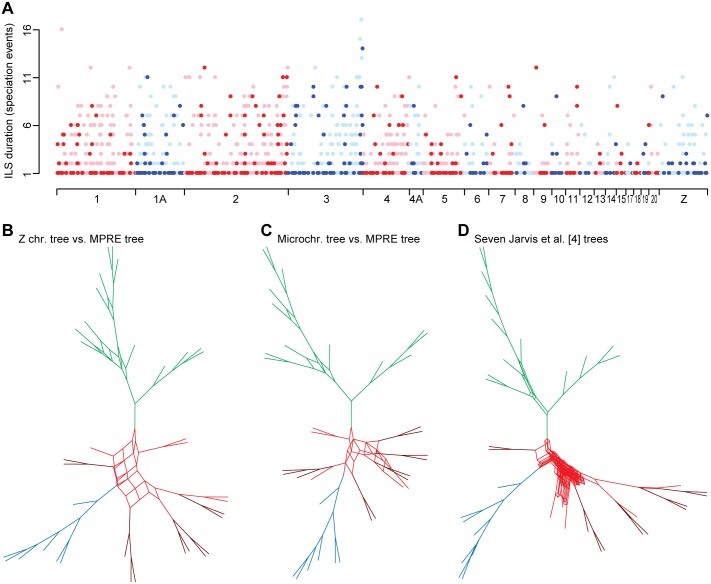
Genomic location of rare genomic changes reveals prevalence of incomplete lineage sorting across all chromosomes.(A) Distribution of RE markers across the chromosomes of the zebra finch genome plotted against per-marker count of speciation events during which respective ILS persisted (S1 Table). Locations of intronic markers are indicated in dark colors, while putatively intergenic markers are denoted in light colors. (B–D) Supernetworks [31] illustrate the complex reticulations of topology conflicts between compared trees. These conflicts exhibit highly similar distributions (cf. Fig 4A) in supernetwork comparisons between the MPRE tree (Fig 1B, S2 Data) and a tree based on 114 Z-chromosomal REs (S2 Data) (B), between the MPRE tree and a tree based on 140 REs from microchromosomes (i.e., all chromosomes smaller than 20 Mb; S2 Data) (C), and among seven different genome-level sequence analyses from Jarvis et al. [4] (D). Colors of reticulations correspond to the coloration used in Fig 4 for discerning the three adaptive radiations of Neoaves. See Supporting Information (S3 and S4 Figs) for species labels and details on the trees compared in supernetworks.